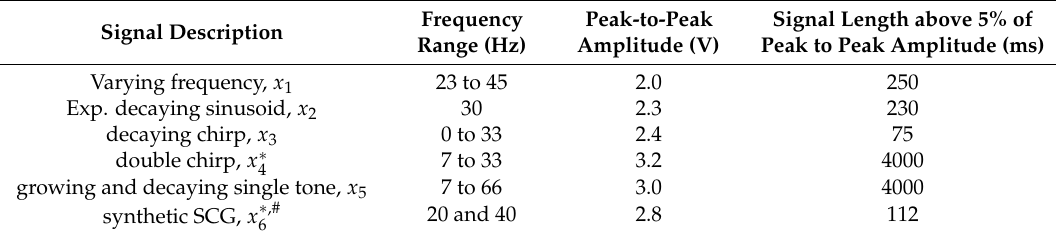
Table 2. Description of synthetic signals used in the current